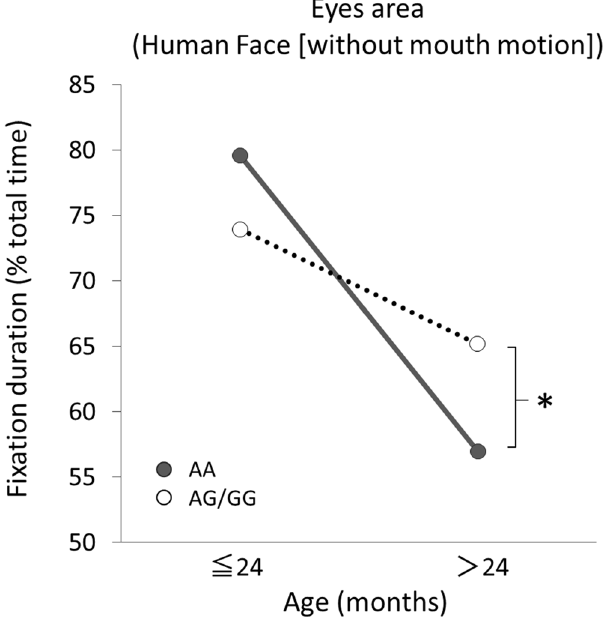
Figure 5. Interaction between genotype and age in visual attention to the eyes as social cues. Solid line is the OXTR rs53576 AA group (n = 62); dotted line is the OXTR G-carrier group (n = 87). * p <